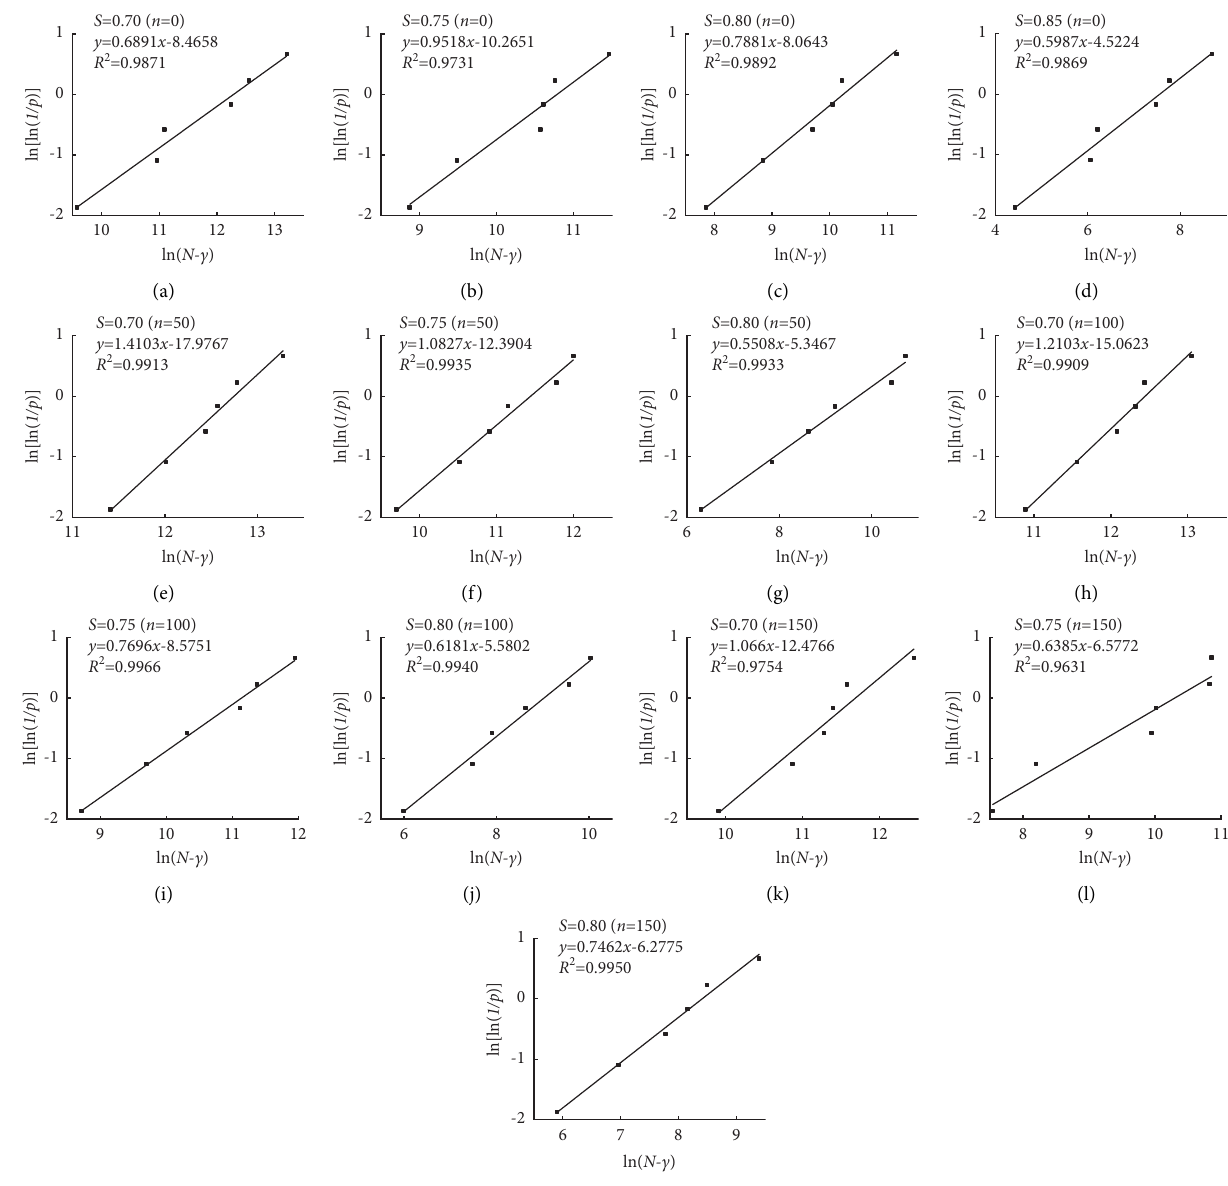
Figure 9: Three-parameter Weibull distribution test of the fatigue life of AASC. (a) S � 0.70 ( n � 0), y � 0.6891 x − 8.4658, R 2 � 0.9871; (b) S � 0.75 ( n � 0), y � 0.9518 x − 10.2651, R 2 � 0.9731; (c) S � 0.80 ( n � 0), y � 0.7881 x − 8.0643, R 2 � 0.9892; (d) S � 0.85 ( n � 0), y � 0.5987 x − 4.5224, R 2 � 0.9869; (e) S � 0.70 ( n � 50), y � 1.4103 x − 17.9767, R 2 � 0.9913; (f) S � 0.75 ( n � 50), y � 1.0827 x − 12.3904,